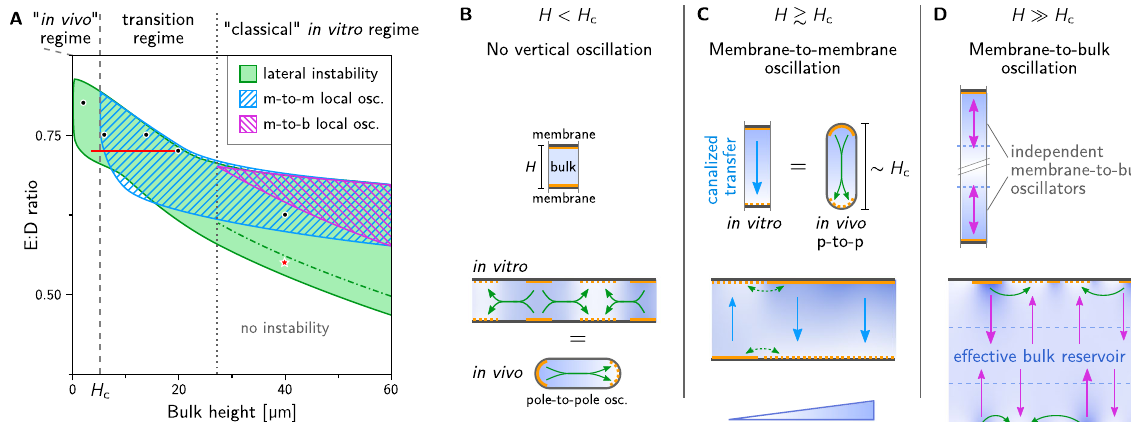
Fig. 2 Distinct lateral and vertical mass-transport modes at different bulk heights. A Phase diagram for bulk height and E : D ratio showing three types of mass-transport modes, identi fi ed by linear stability analysis, that exist in overlapping regimes: lateral instability (green), local membrane-to-membrane instability ("m-to-m'', blue) and local membrane-to-bulk instability ("m-to-b'', magenta). See Supplementary Fig. 3 for representative dispersion relations in the various regimes. Green dot-dashed line marking the transition from chaotic to coherent patterns 5 . A representative example of a chaotic pattern is shown in Supplementary Movie 4 for the parameter combination marked by the red star. Black dots mark the parameters used for the simulations shown in Fig. 1d. Red line: parameter range for adiabatic sweeps shown in Supplementary Fig. 6 demonstrating hysteresis as a signature of multistability. Panels B – D illustrate the mass-transport modes at different bulk heights. The top row shows laterally isolated compartments to illustrate local vertical oscillations due to vertical bulk gradients. The bottom row illustrates the interplay of lateral and vertical mass-transport modes in a laterally extended system. B For low bulk height, the bulk height is too small for signi fi cant vertical concentration gradients to form. Hence, a laterally isolated compartment does not exhibit any instabilities (top). In a laterally extended system (bottom), exchange of mass can drive a lateral instability (green arrows); see Supplementary Movie 5. The cartoon of an E. coli cell illustrates that this instability also underlies pattern formation in vivo; see Supplementary Movies 19 and 20. C For bulk heights above H c , vertical concentration gradients become signi fi cant enough to enable vertical membrane-to-membrane oscillations (blue arrows); see Supplementary Movie 6. These oscillations do not require lateral exchange of mass, i.e., they occur in a laterally isolated bulk column (top). The cartoon of an E. coli cell illustrates that the membrane-to-membrane oscillations in a laterally isolated compartment can also be pictured as equivalent to in vivo pole- to-pole oscillations. The laterally extended in vitro system constitutes a continuum of such oscillators (bottom). D For bulk heights larger than the penetration depth of vertical gradients, the top and bottom membrane effectively decouple (see Supplementary Movies 7 and 8). In this regime, which corresponds to the classical in vitro regime, the bulk in-between the membranes acts as an effective protein reservoir that facilitates membrane-to-bulk